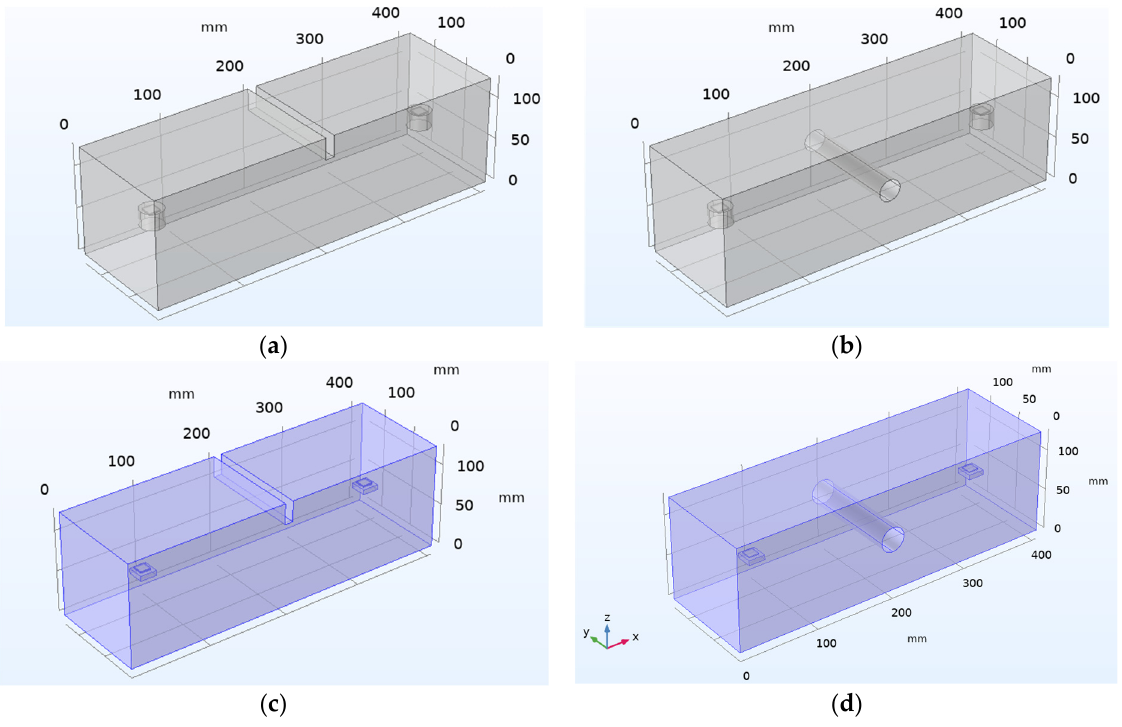
Figure 25. Three-dimensional model geometry: ( a ) Type-B specimen as crack damage; ( b ) Type-C specimen as hole damage; ( c ) Type-B specimen as crack damage with embedded SSUs; ( d ) Type-C specimen as hole damage with embedded SSUs.